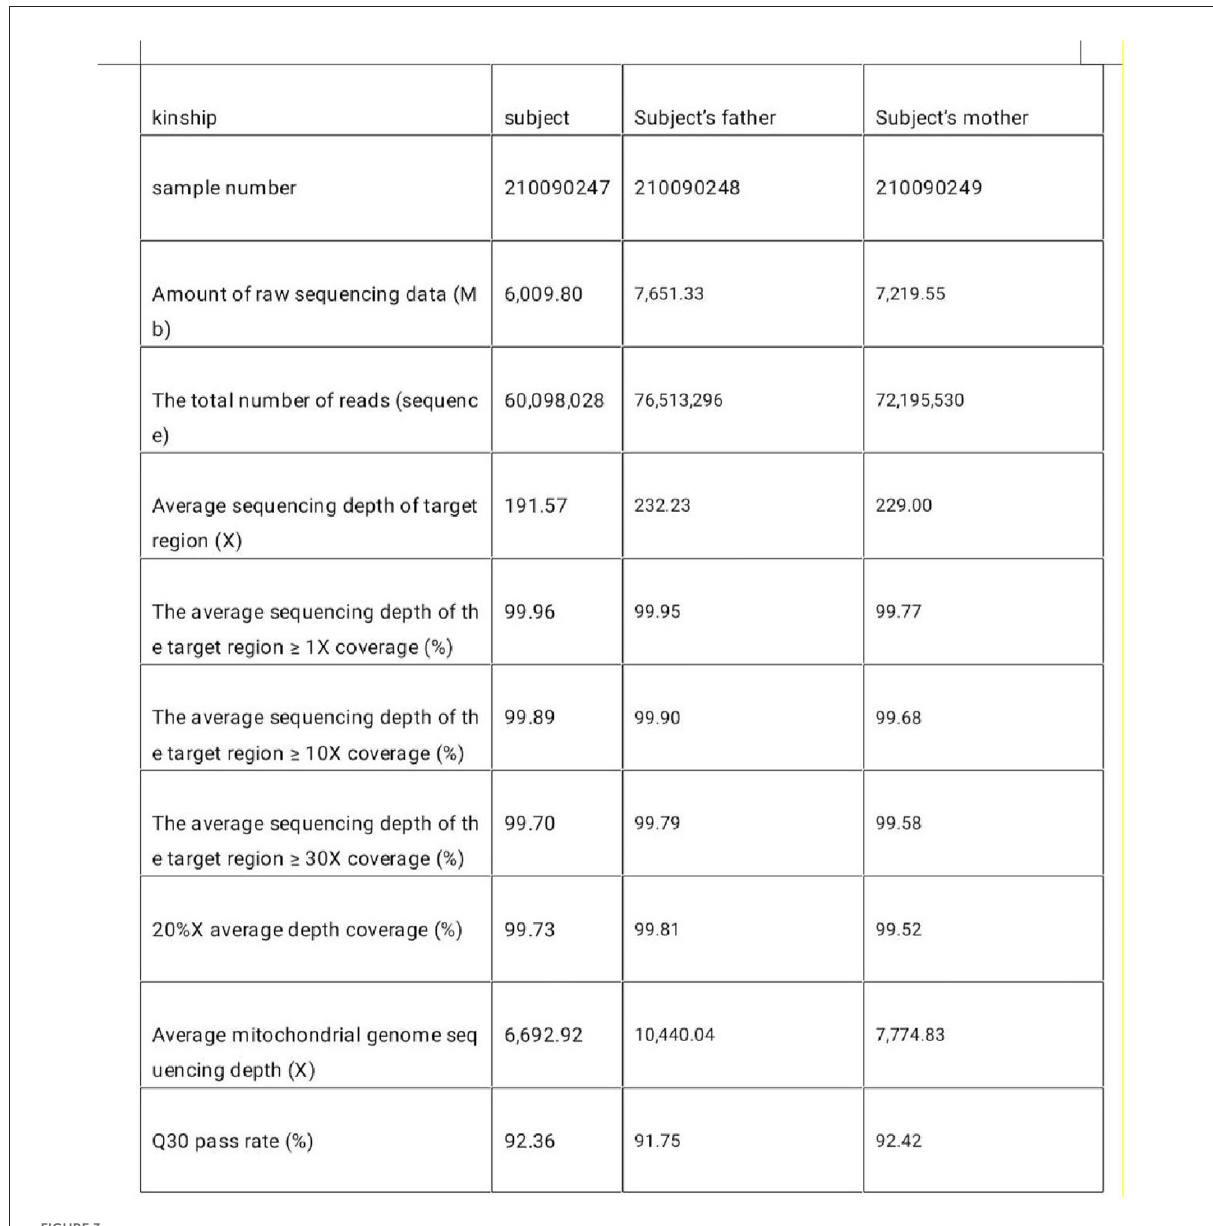
FIGURE3 The target region of the tested sample captures the sequencing